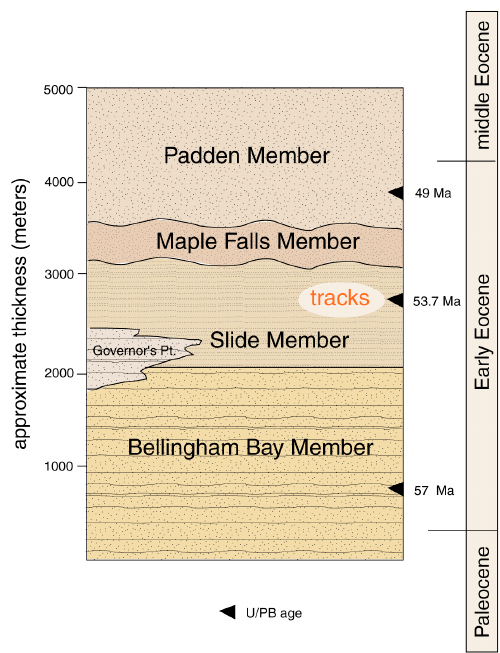
Figure 2. Stratigraphy of the Chuckanut Formation.